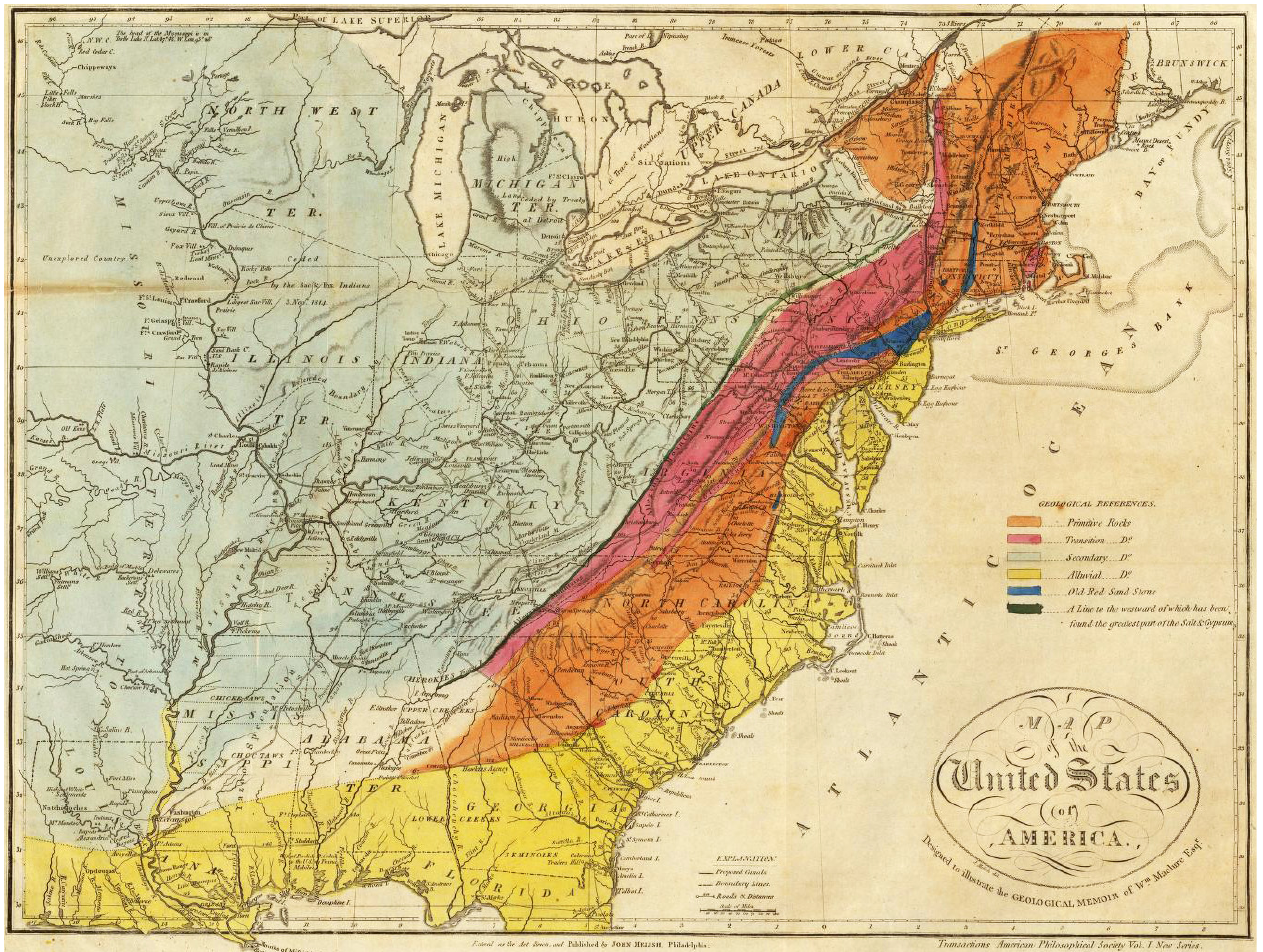
Figure 2. Maclure’s (1818) geologic map of the United States. In addition to the standard Wernerian rock classes, the American equivalent of the “Old Red Sandstone” [Triassic basin-fill deposits] of the British Isles, and “a line to the westward of which has been found the greatest part of the Salt & Gypsum” are